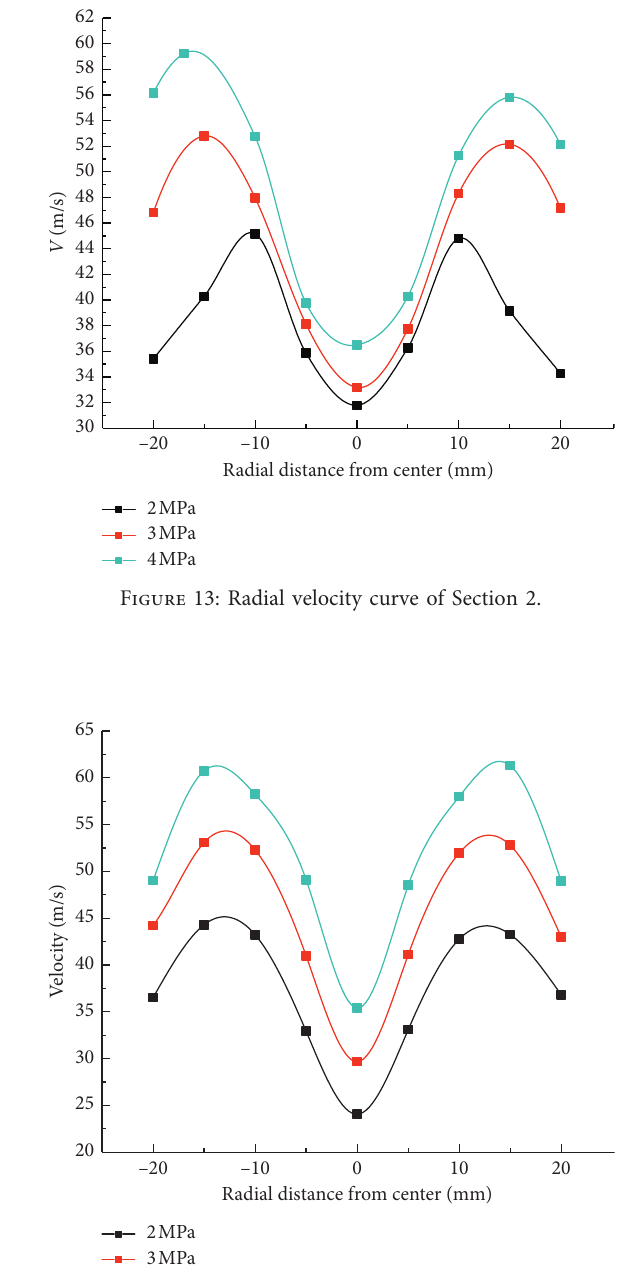
Figure 14: Radial velocity curve of Section